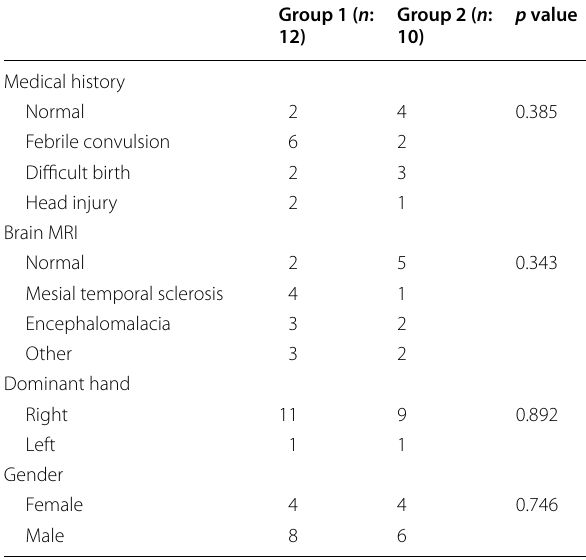
Table 2 Comparison of the of gender, medical history, dominant hand and brain MRI features of G1 and G2